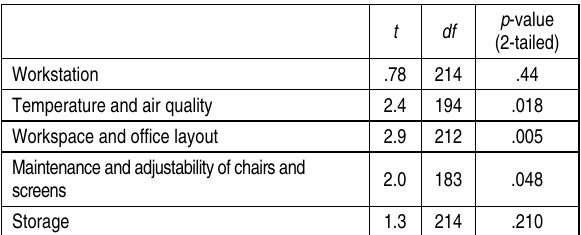
Table 4. t-test for physical work